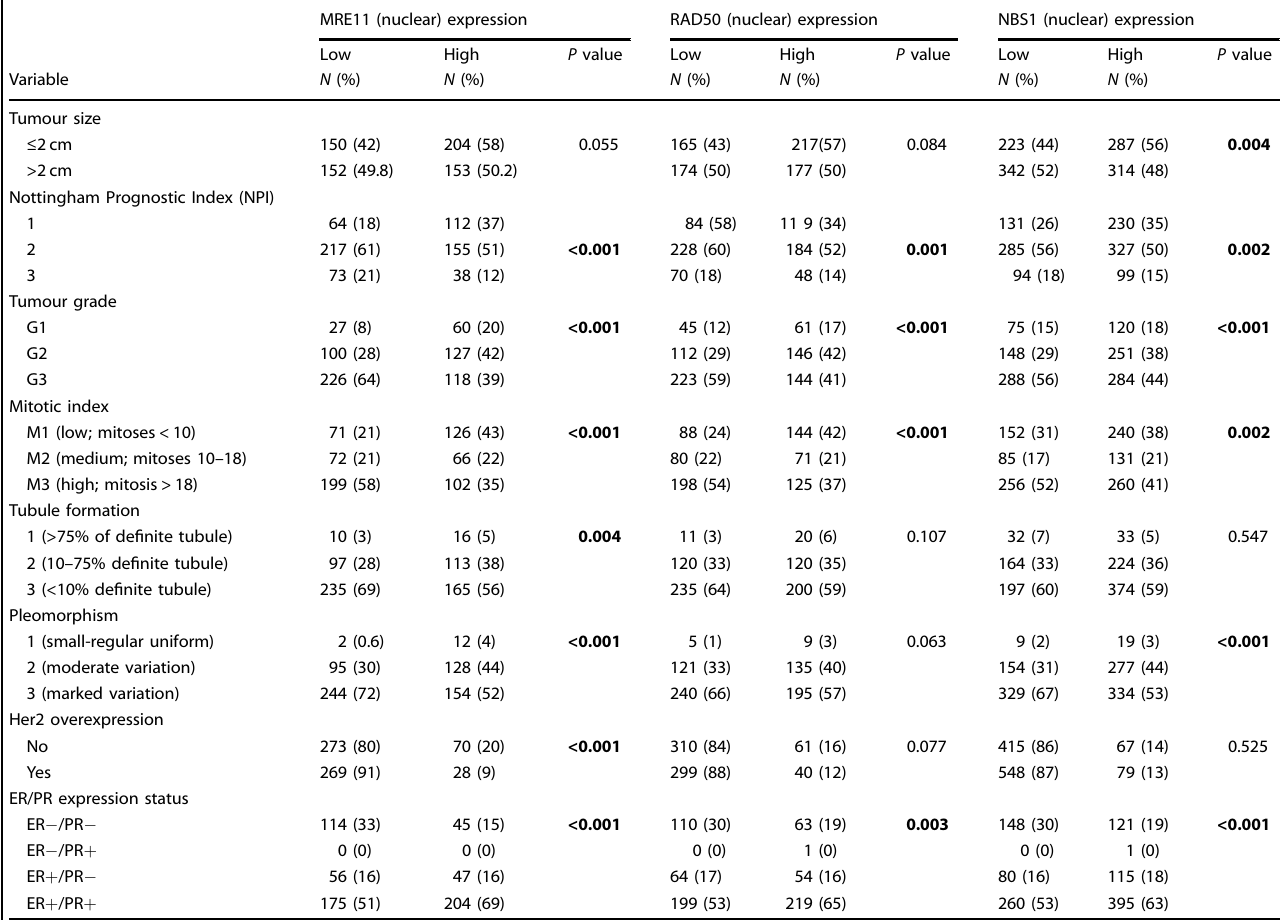
Bold values indicate statistical signi fi cance p